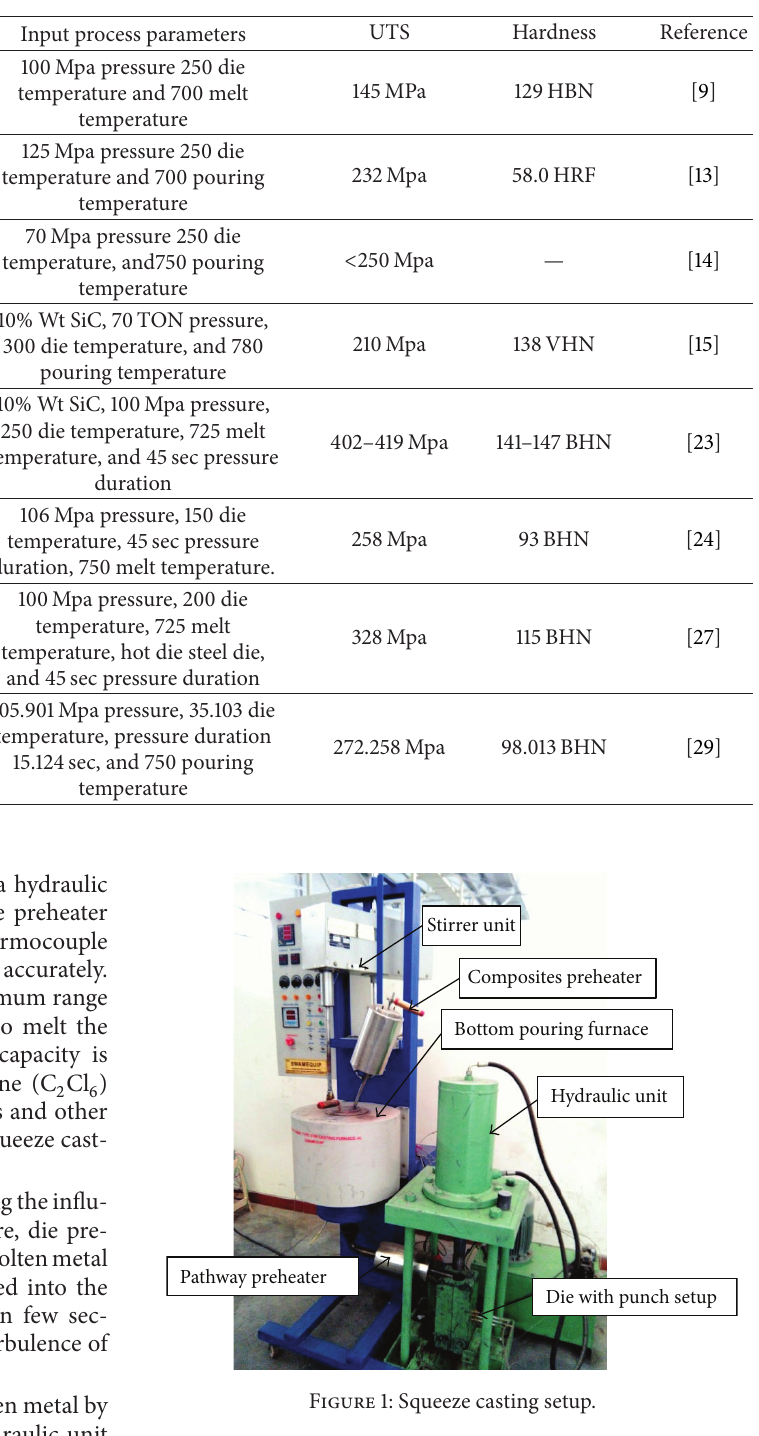
Table 2: Comparison of antecedent research works.